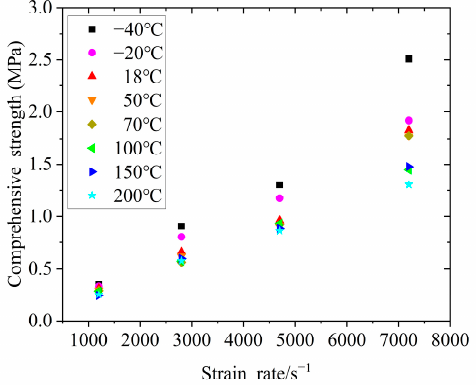
Figure 8. Relationship between the yield strength and strain rate.